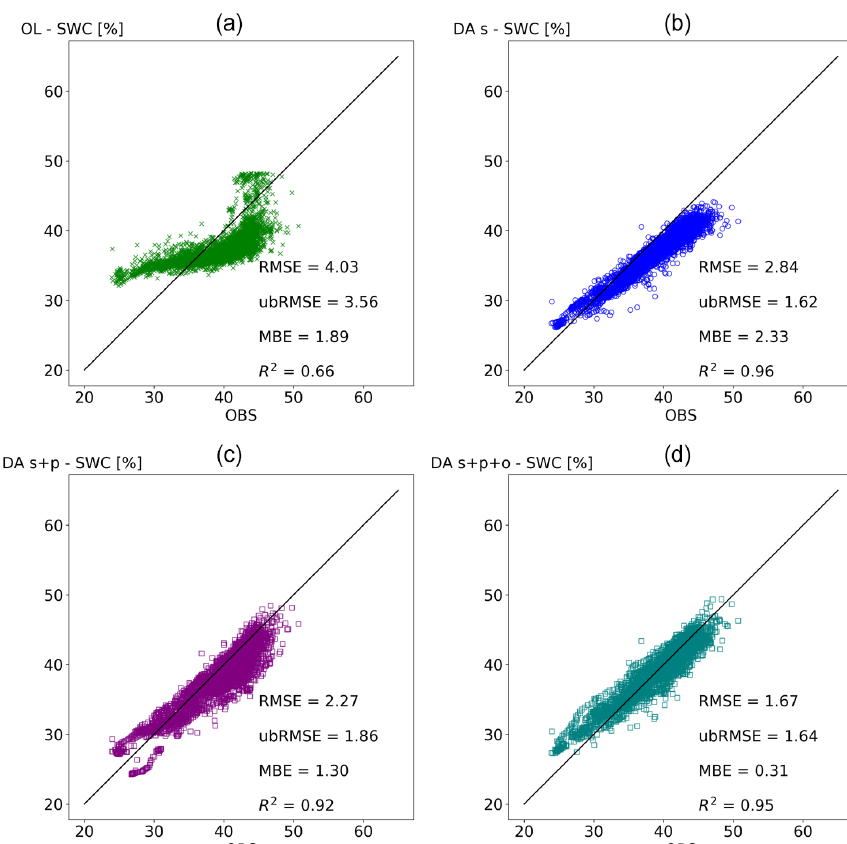
Figure 5. Correlation diagrams for observed (OBS) and simulated soil water content (SWC) at 20cm depth. Each marker shows one daily average. Panel (a) shows open loop (OL), panel (b) shows data assimilation of state variable (DA_s), panel (c) shows data assimilation of state and parameters (DA_s + p), and panel (d) shows data assimilation of state and parameters including organic matter (DA_s + p + o). Each diagram shows root mean square error (RMSE), unbiased root mean square error (ubRMSE), mean bias error (MBE), and squared correlation coefficient ( R 2